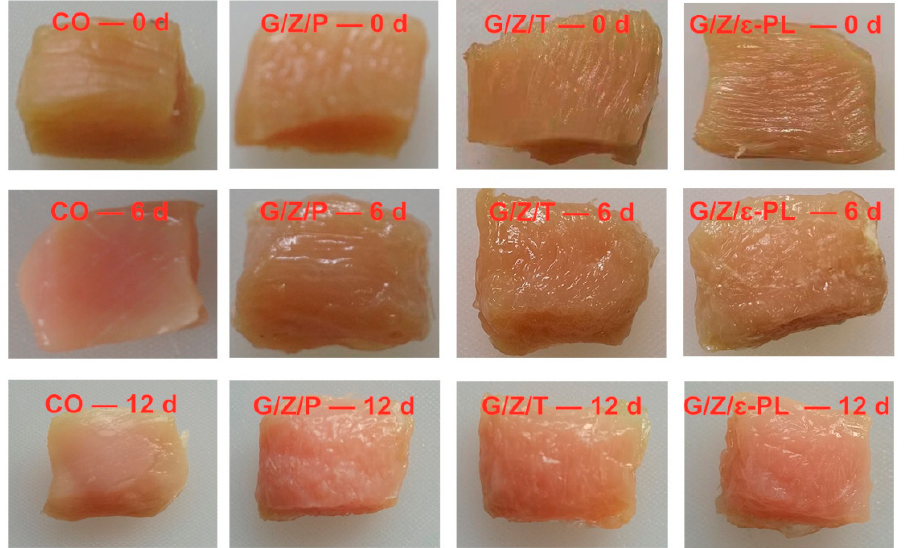
Figure 4. The images of the preservation effect of the gelatine/zein/perillaldehyde, gelatine/zein/thymol and gelatine/zein/ ε -polylysine nanofiber films on chicken breasts (taken from [60]).